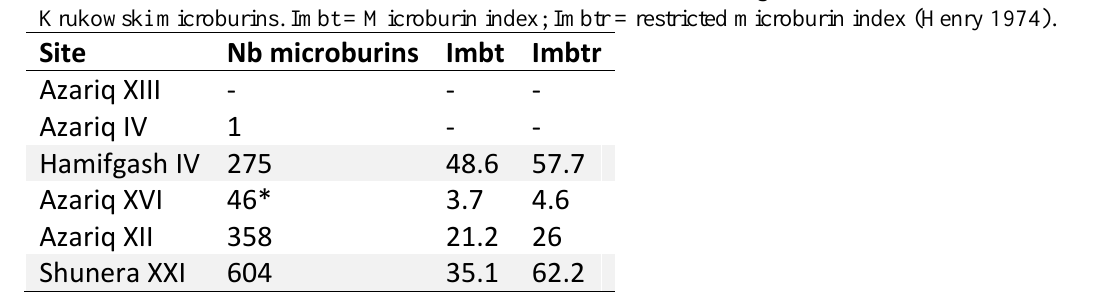
Table 11. Number of microburins and microburin indices (After Goring-Morris 1987). Abbreviations: * Mostly